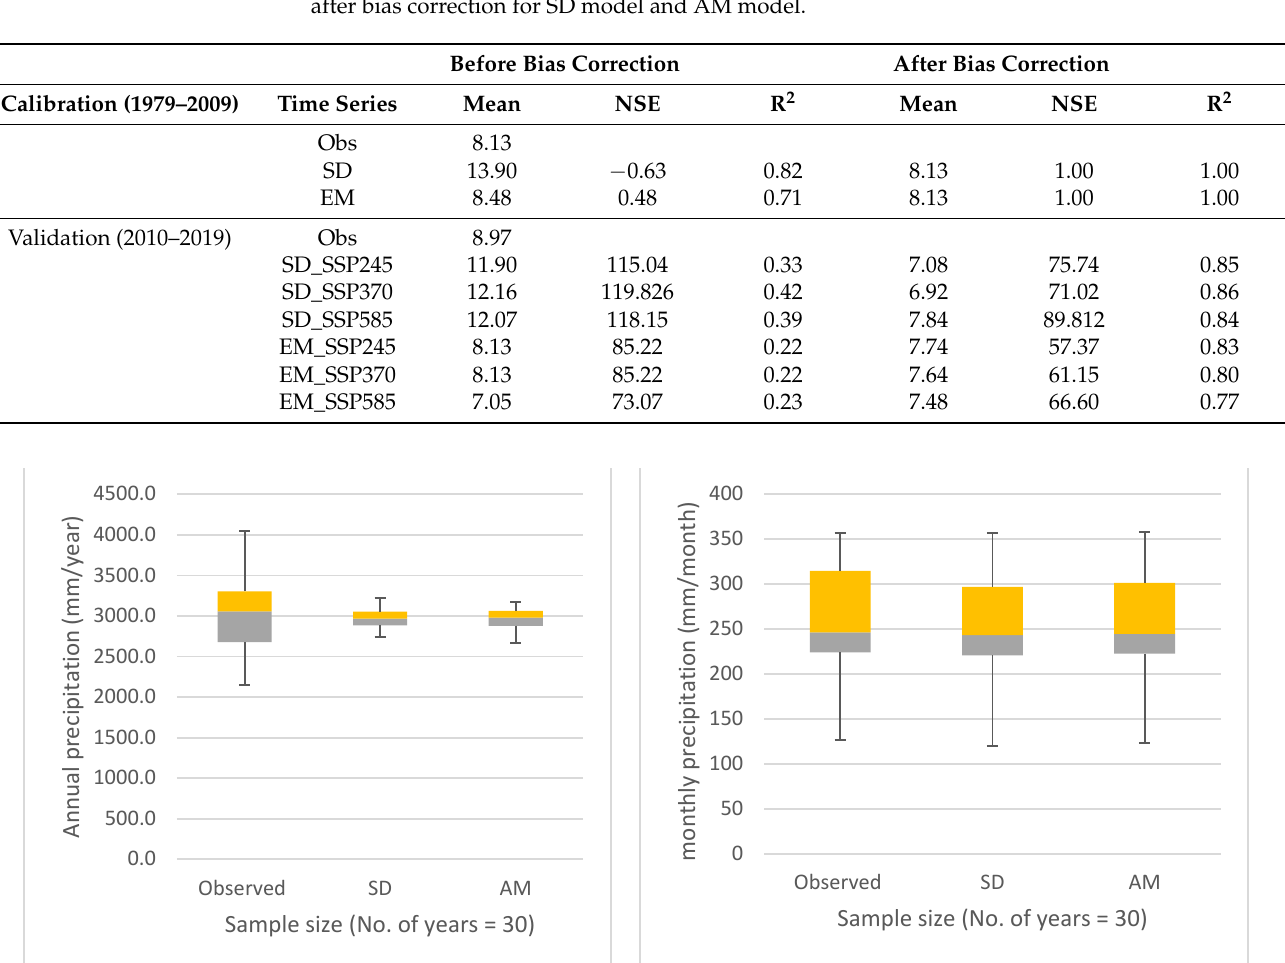
Table 5. Summary of mean and standard deviation for calibration and validation period before and after bias correction for SD model and AM model.